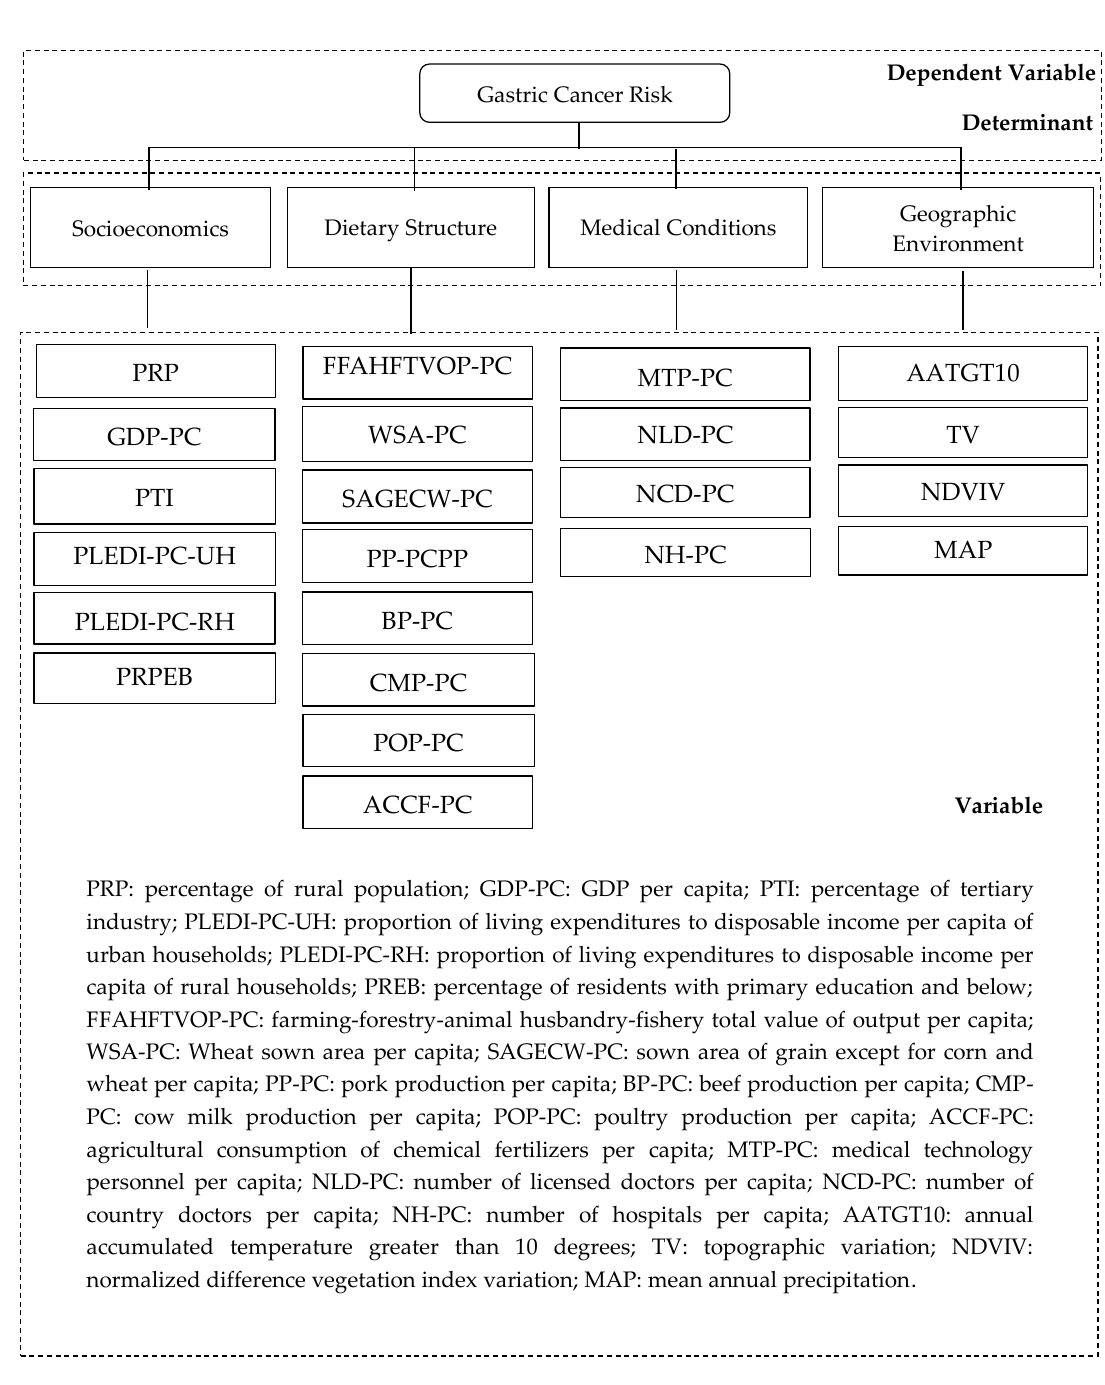
Figure 2. Gastric cancer risk determinants and their variables.